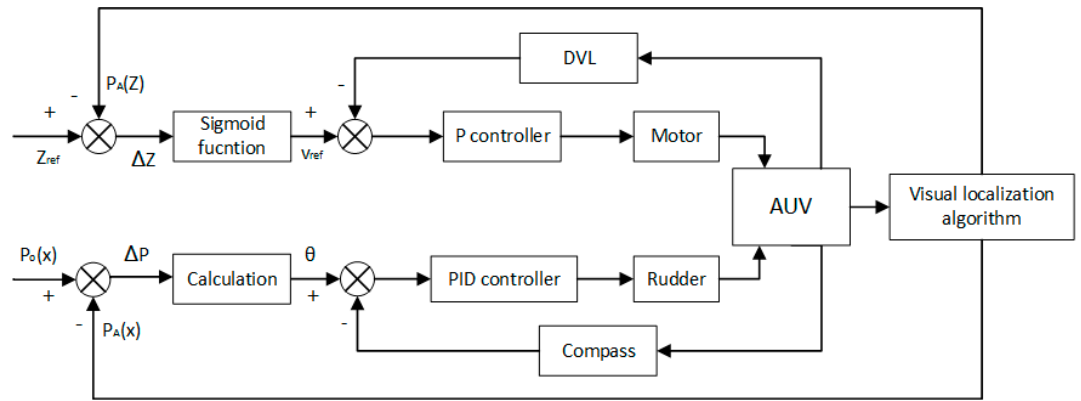
Figure 14. The schematic diagram of the control strategy on the horizontal plane.